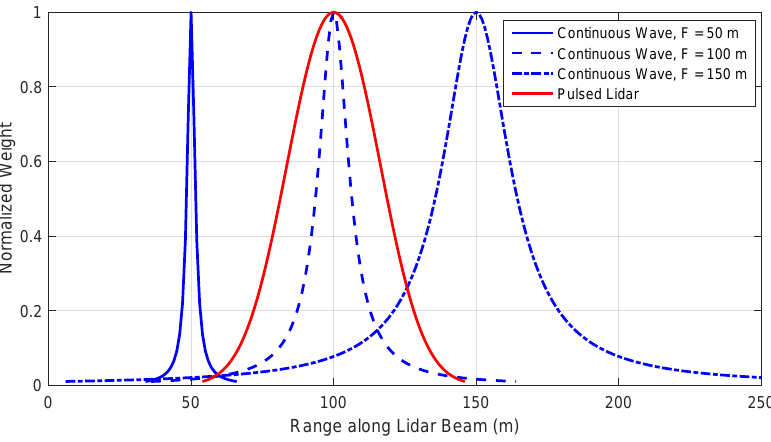
Figure 2. Normalized range weighting functions for a continuous wave (CW) lidar with focus distances of 50 m, 100 m, and 150 m as well as a pulsed